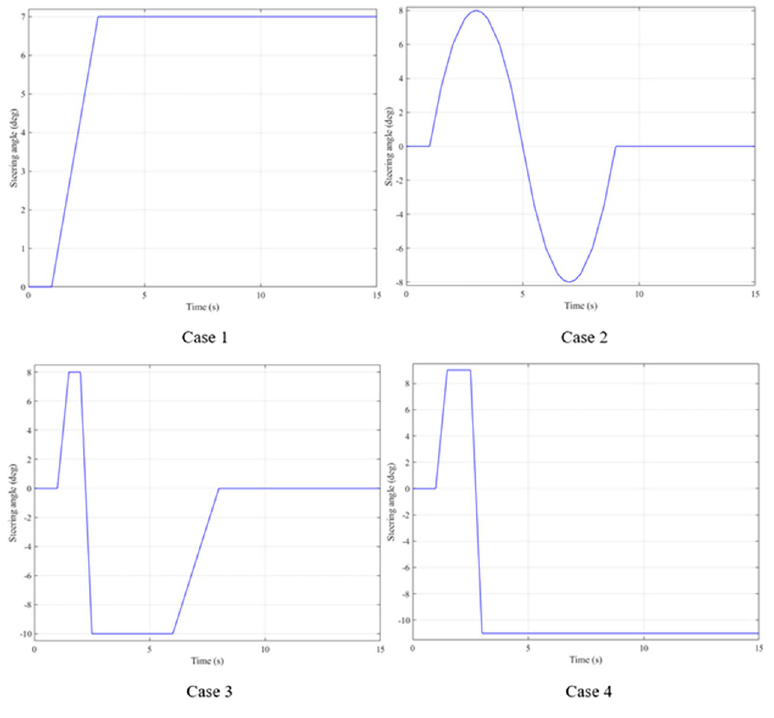
Fig 6. Steering angle.